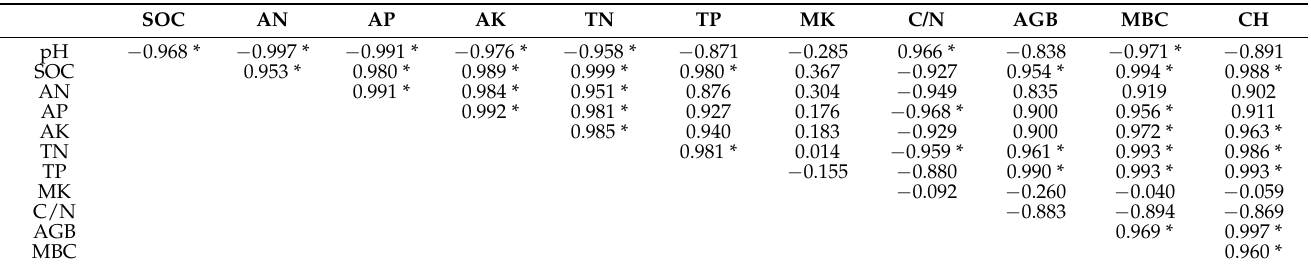
Figure 4. Redundancy analysis (RDA) of biological characteristics and chemical indicators of the soil for different treatments (permutation test: p = 0.001). Table 4. Correlation analysis of chemical properties and biological characteristics of the